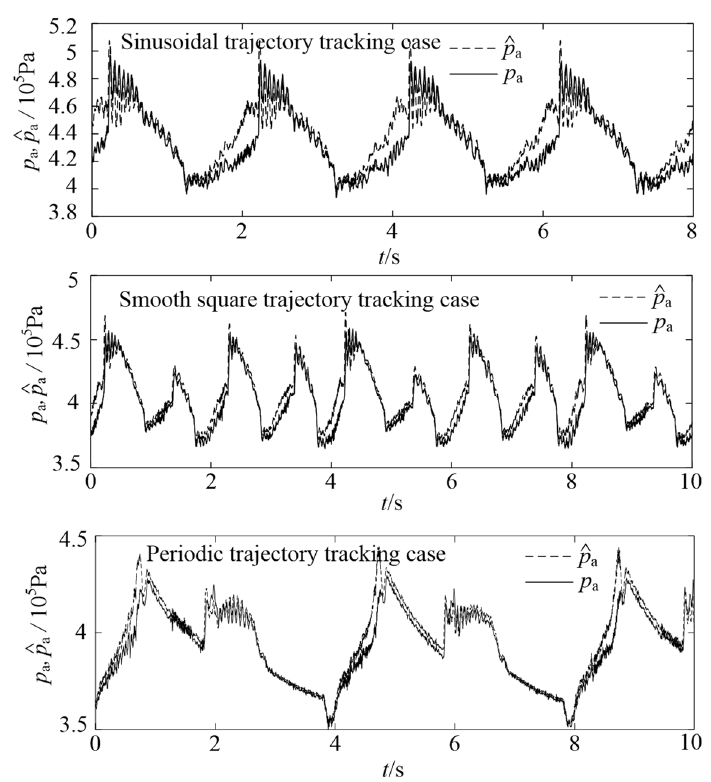
Figure 8. Actual and observed chamber pressure for the system tracking three different types of references.